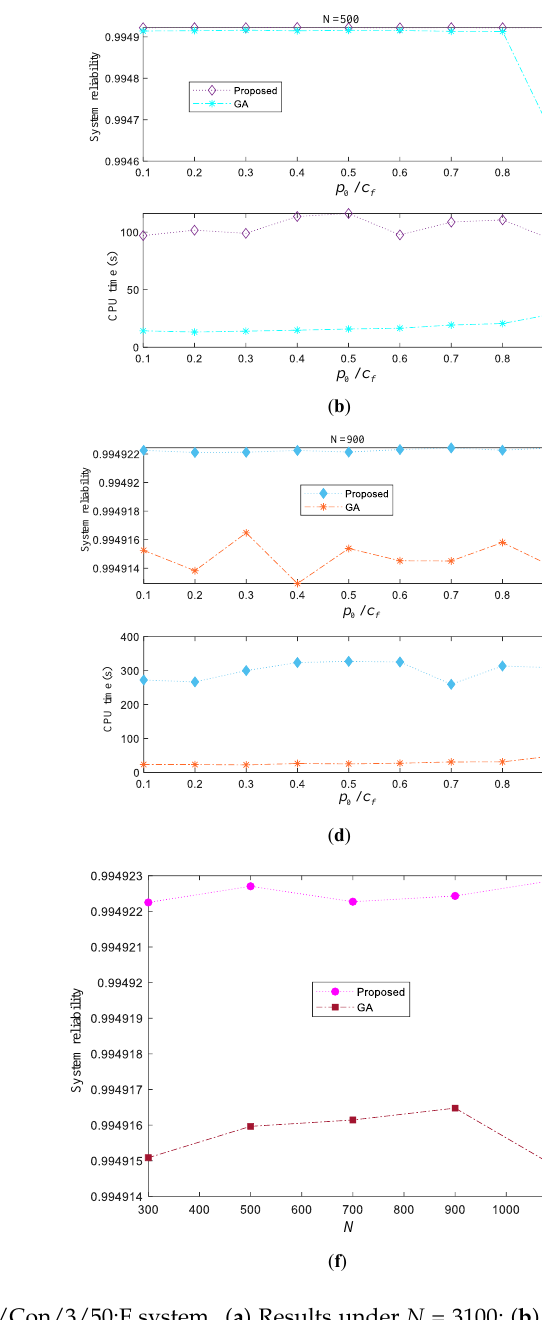
Table 2. Optimal solutions of the Lin/Con/3/50:F system . GA